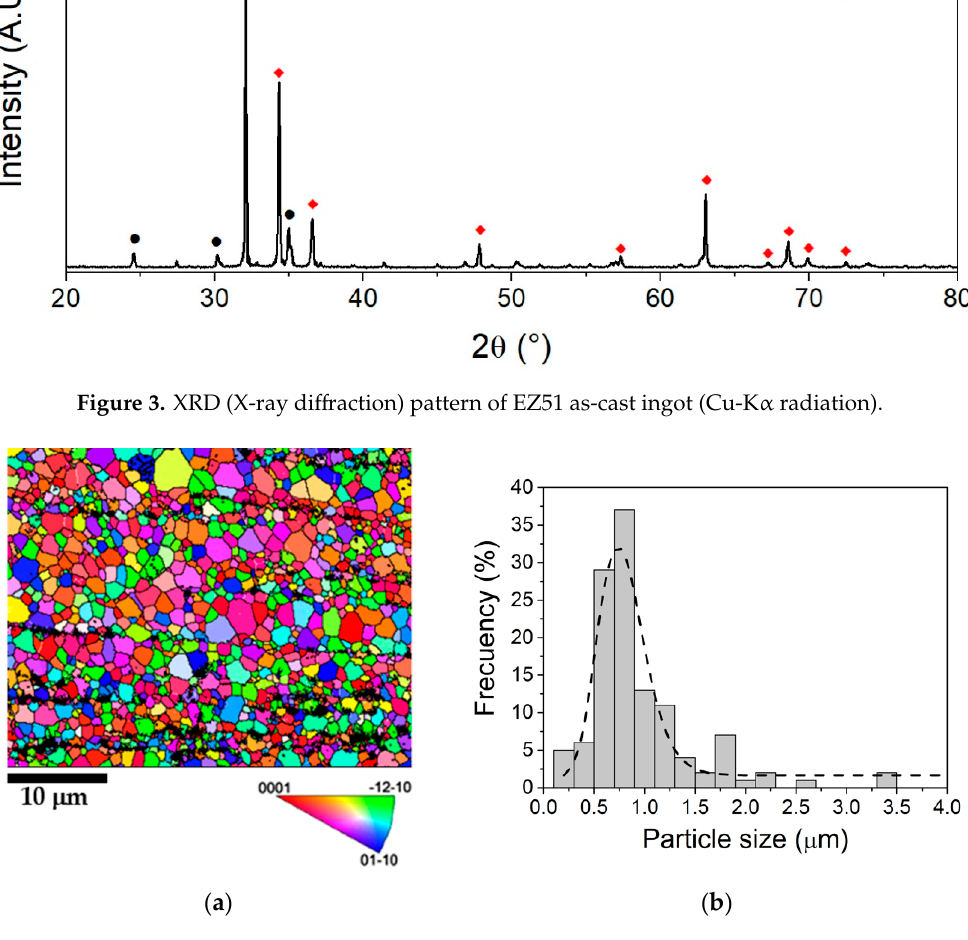
Figure 4. ( a ) EBSD (Electron Backscattered Diffraction) map showing the grain size and grain orientation; and ( b ) particle size distribution of Mg 12 Nd phase in the extruded bar EZ51-IM350.